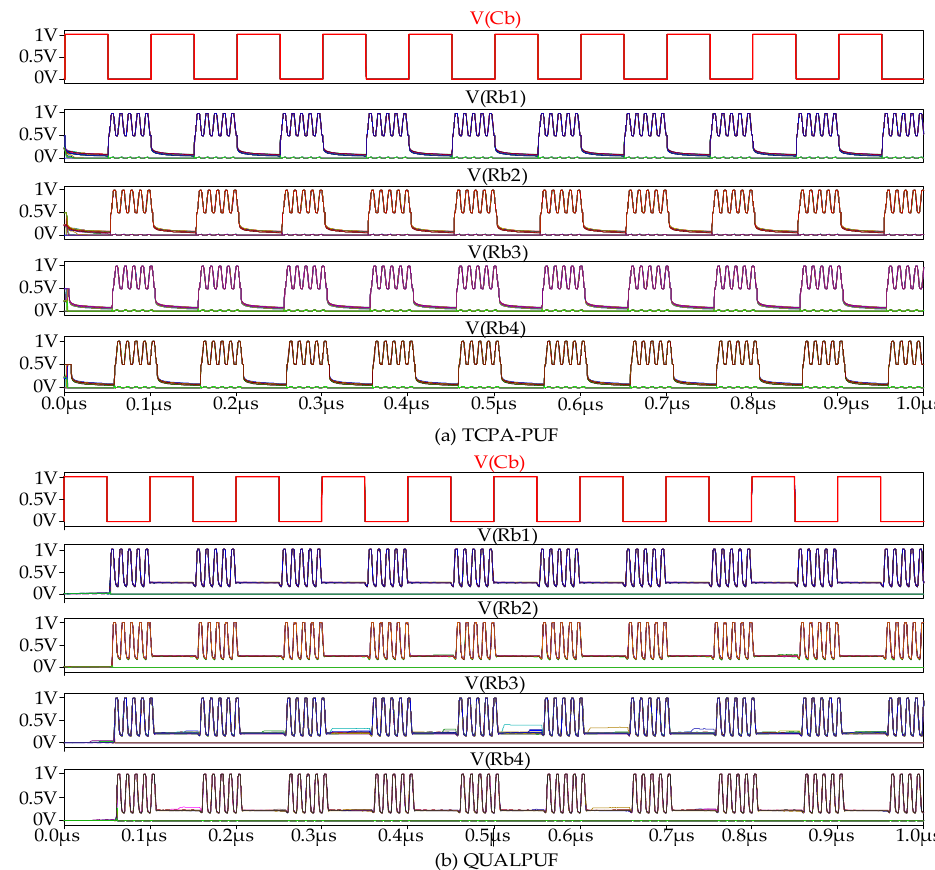
Figure 5. Proposed 4-bits FinFET TPCA-PUF architecture .